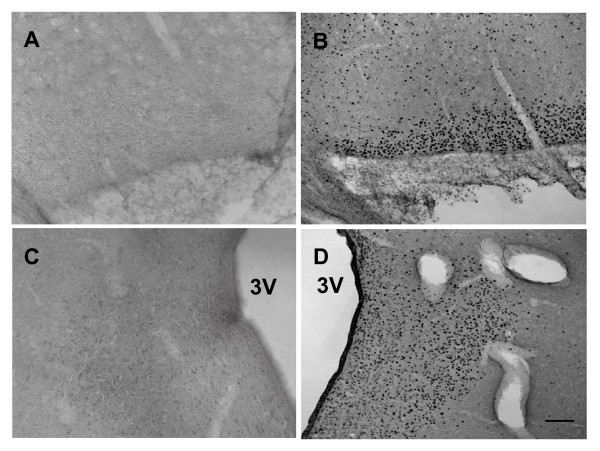
FOS-ir induced by i.c.v. carbachol in the fetal SON and PVN. SON (upper panel) and PVN (bottom panel). A and C: the animal treated with i.c.v. vehicle; B and D: the animal injected with i.c.v. carbachol (3 μg/kg). 3V: the third ventricle. Scale bar = 200 μm.